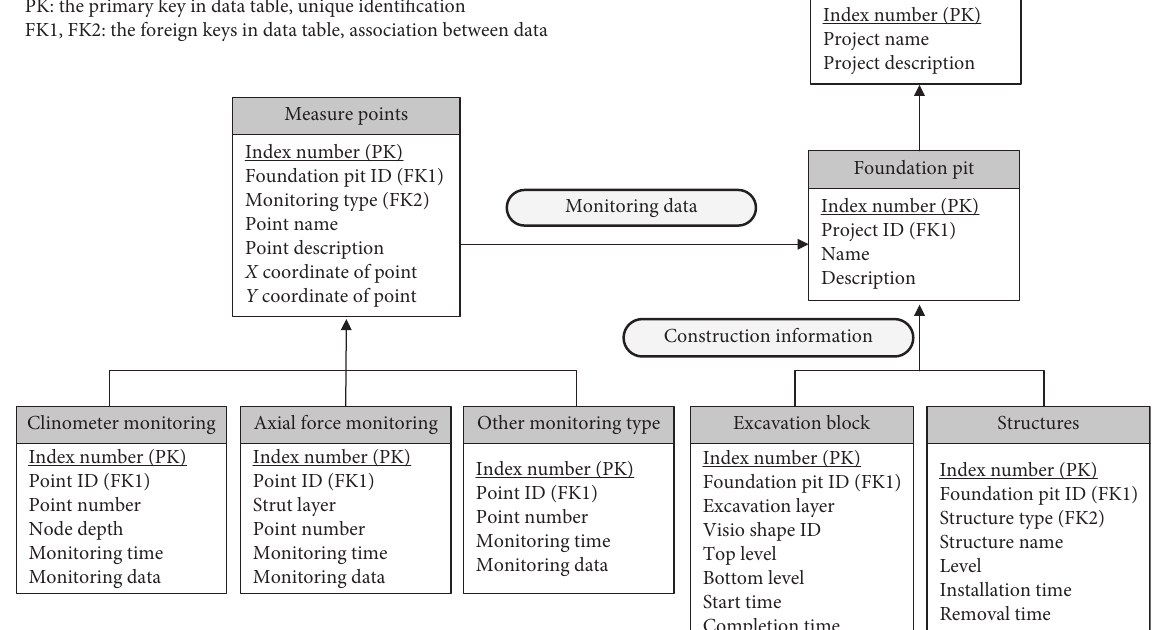
Figure 3: Excavation project database relationship